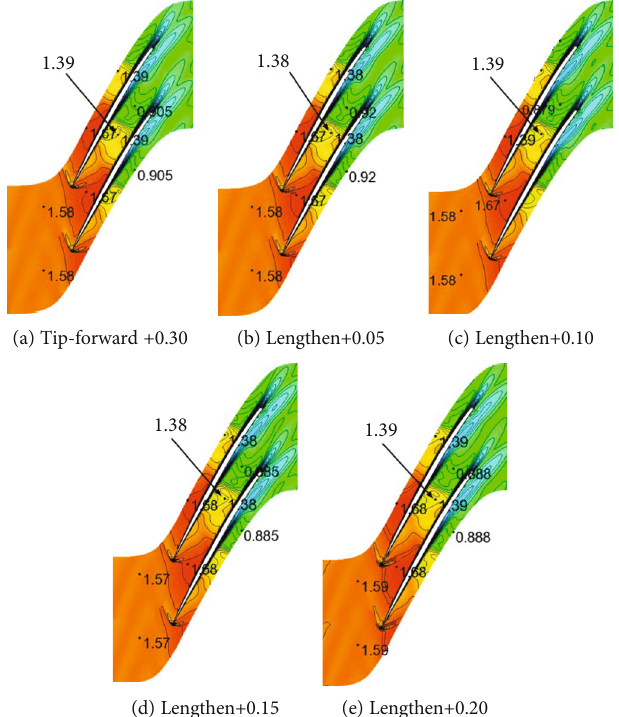
Figure 27: Mach number contours for 90% span at the design point.